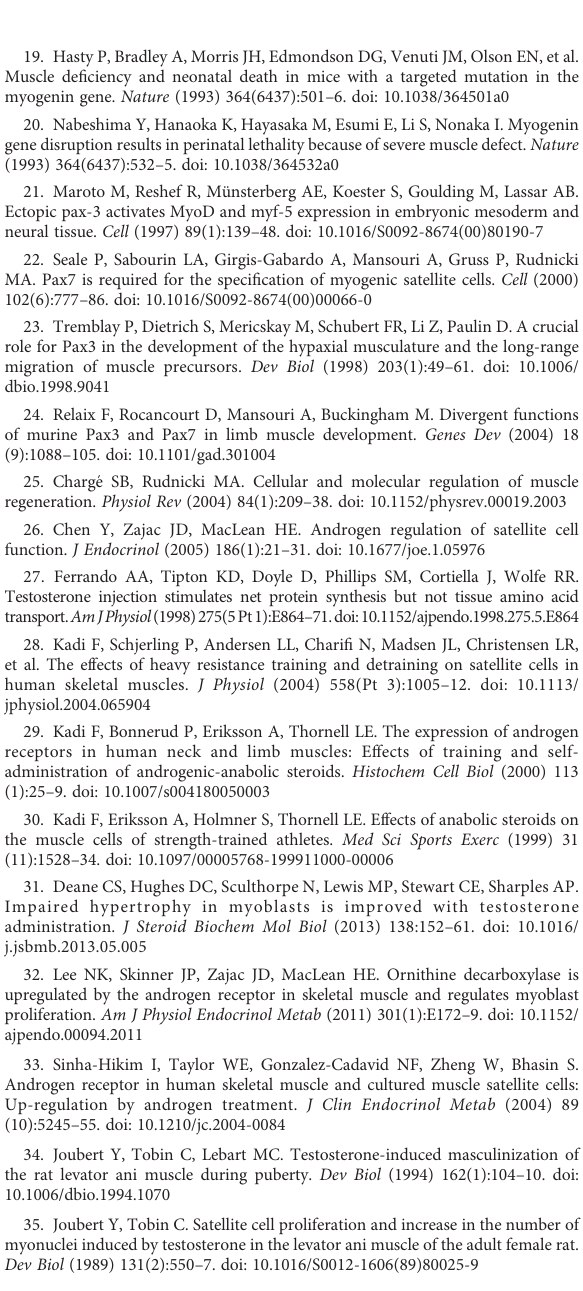
SUPPLEMENTARY TABLE 1 A summary of studies detailing the effect of androgen on muscle as mediated by different cell population found in the